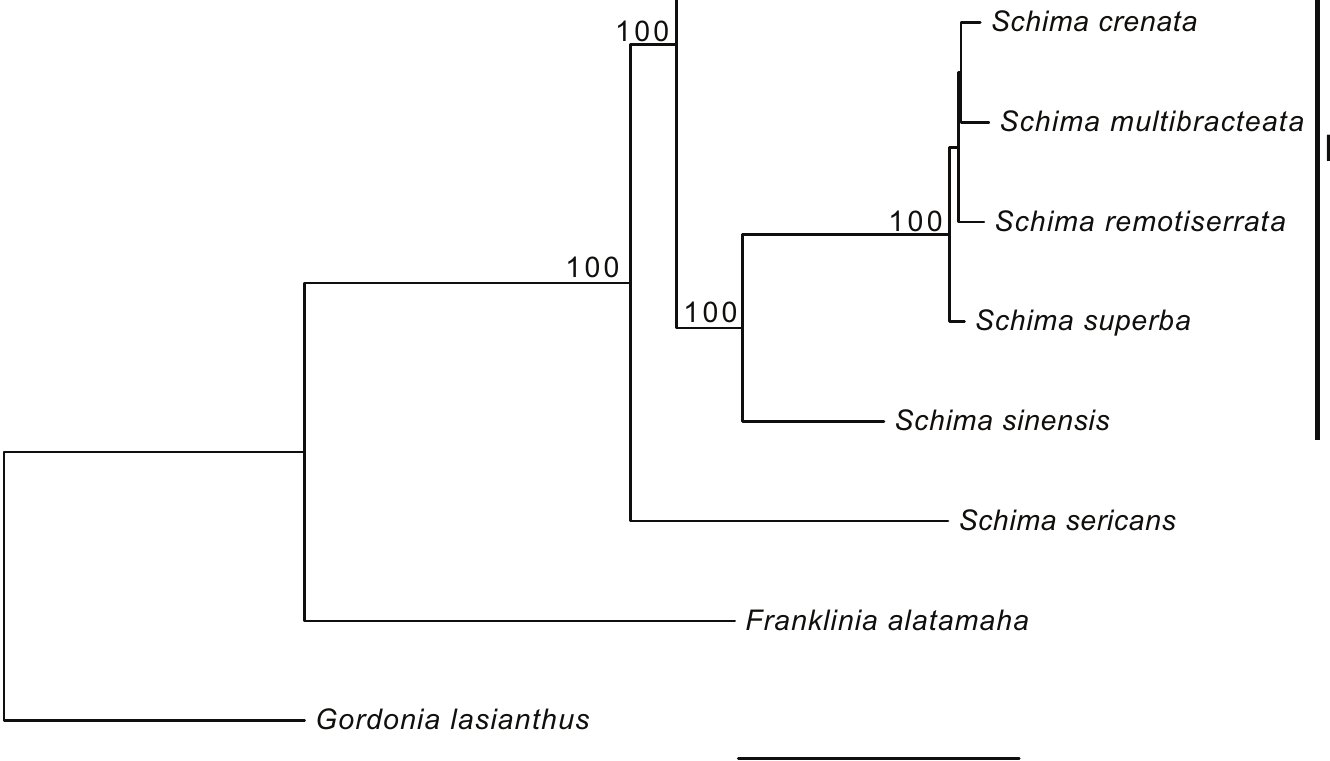
Fig 5. Phylogenetic relationships among the 11 Schima species. The phylogenetic tree was reconstructed using the wholechloroplastgenomedata set minus a copy of the IR region. Numbersabove the branches show bootstrapsupport values that are above80%.